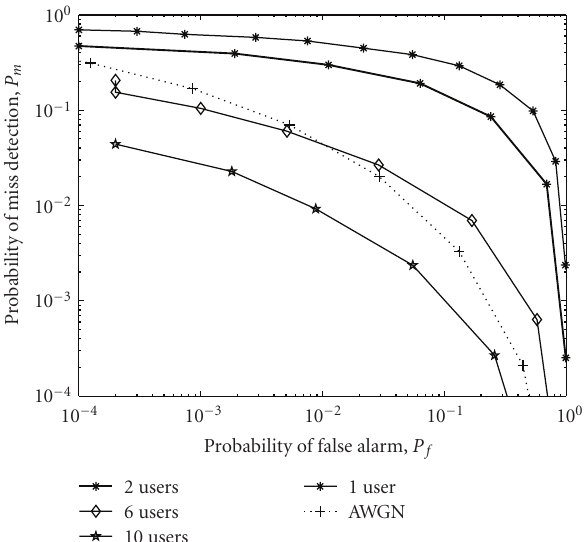
Figure 6: Probability of miss detection versus minimum detected SNR in shadow fading, P f = 10 − 1 , σ dB = 6, γ = 5dB, N =